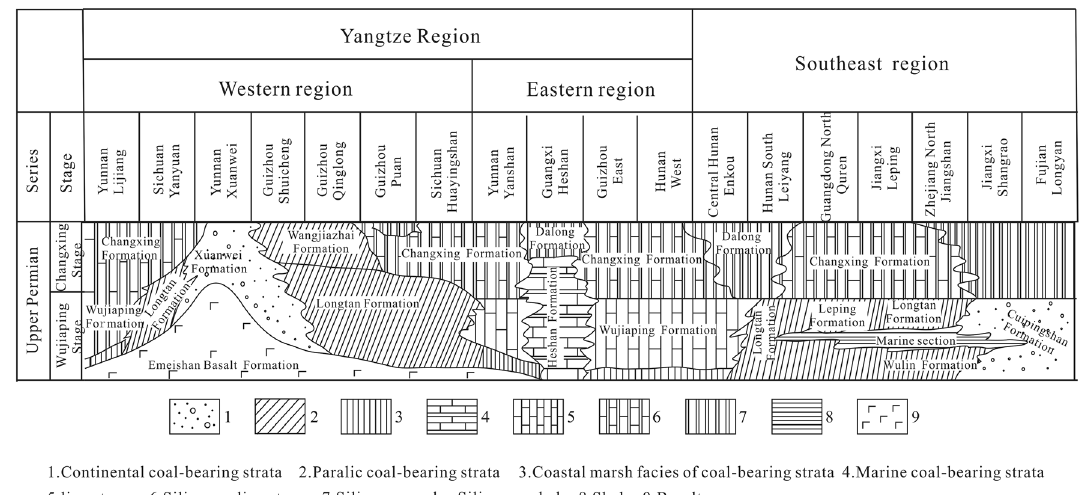
Fig. 7 Subcorrelation and depositional types of the lithological formations of the Late Permian in the South China CAA (revised after Zhang, 1995; Shao et al.